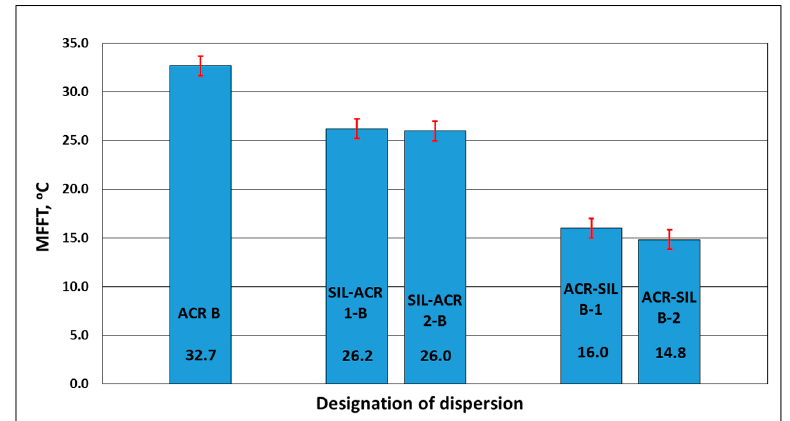
Figure 8. Comparison of MFFT determined for hybrid dispersions SIL-ACR and ACR-SIL. MFFT of starting ACR dispersion used for synthesis of ACR-SIL dispersions is also shown.